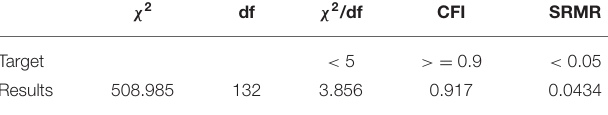
TABLE 2 | The model fit test results and the target value performed using AMOS.